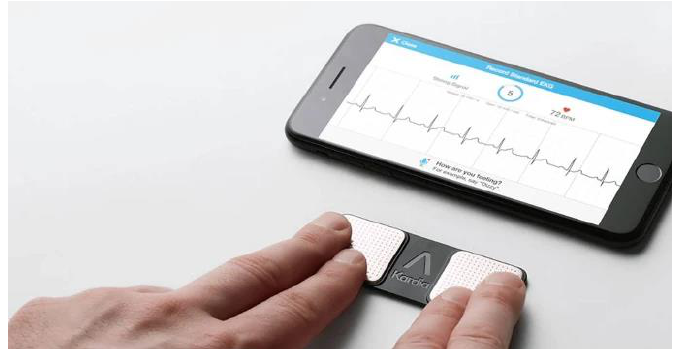
Figure 4. AliveCor Kardia Mobile device and its application.